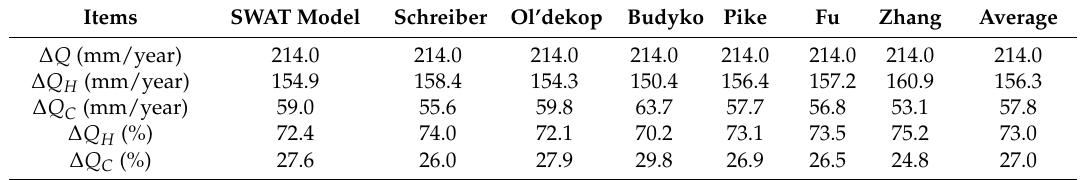
Table 8. Verification of the hydrological modeling approach (Seom River